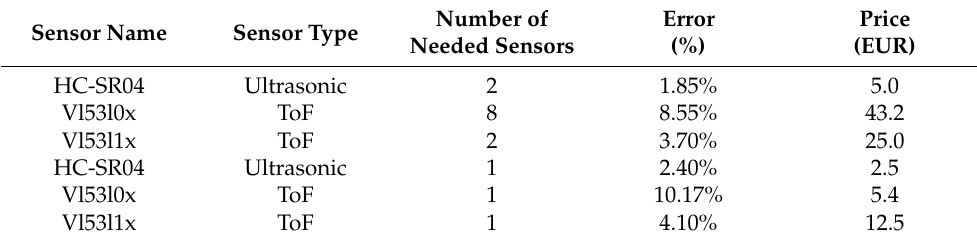
Table 9. Price comparison of the devices made from coupled